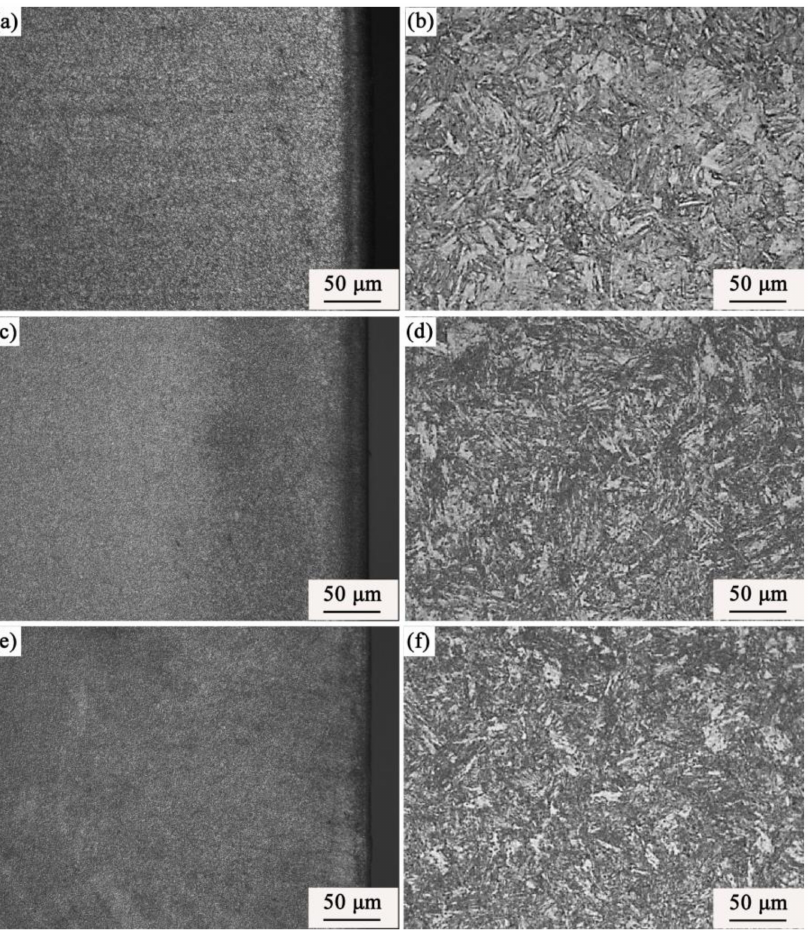
Figure 9. Microstructure of the carburized layer on the three samples—( a ) carburized surface layer without RE; ( b ) core after carburizing without RE; ( c ) carburized surface layer after La implantation; ( d ) core after La implantation; ( e ) carburized surface layer after Y implantation; and ( f ) core after Y